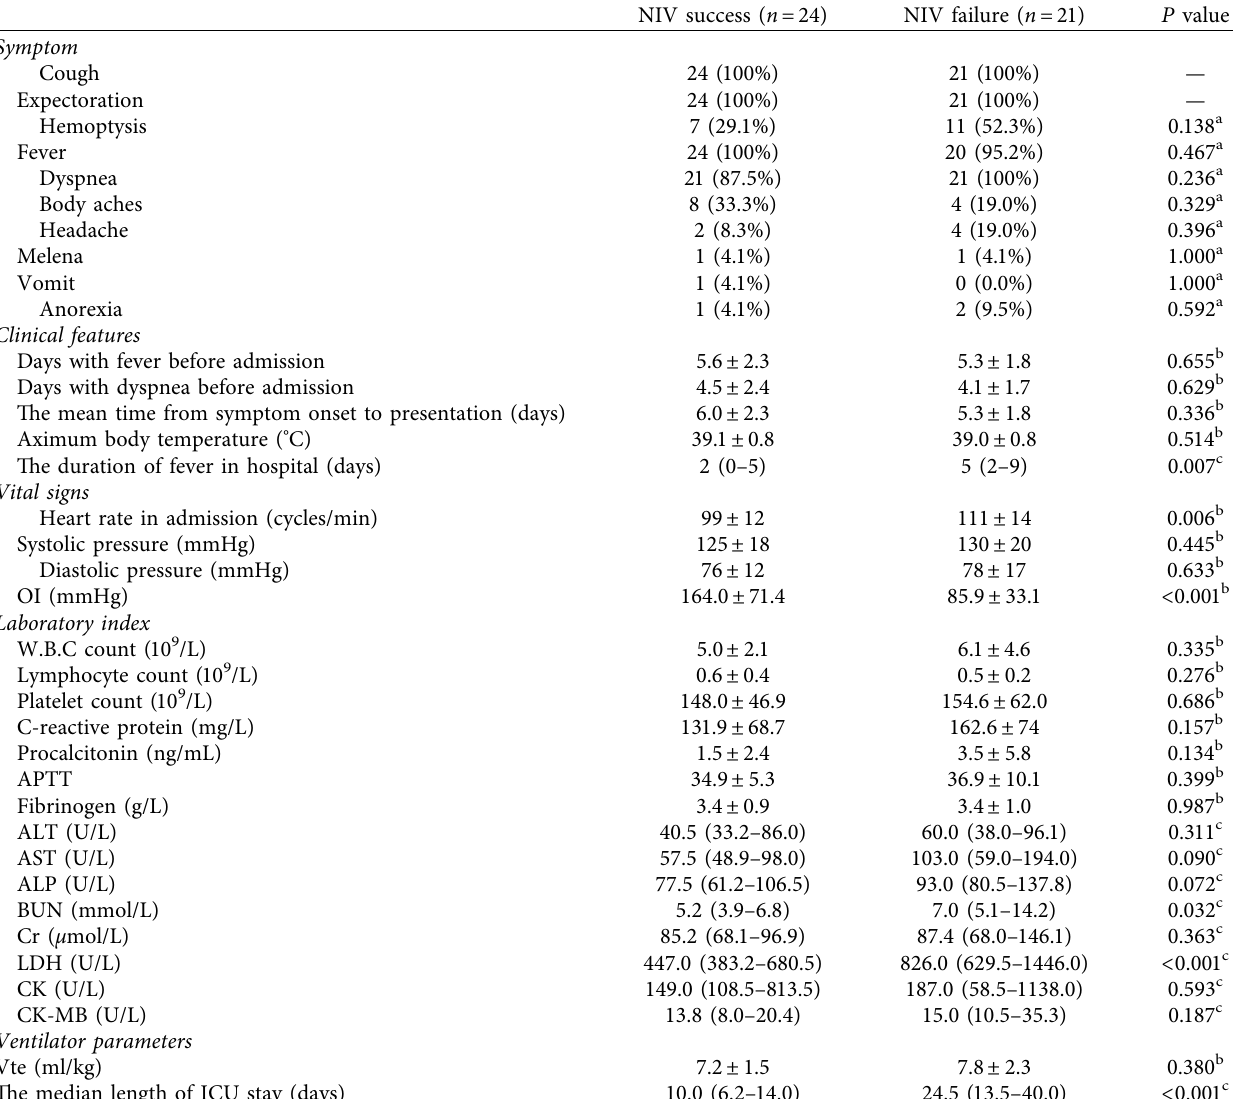
Table 2: Laboratory indexes, clinical symptoms, and physical examination of 45 patients with infuenza A-associated acute respiratory distress